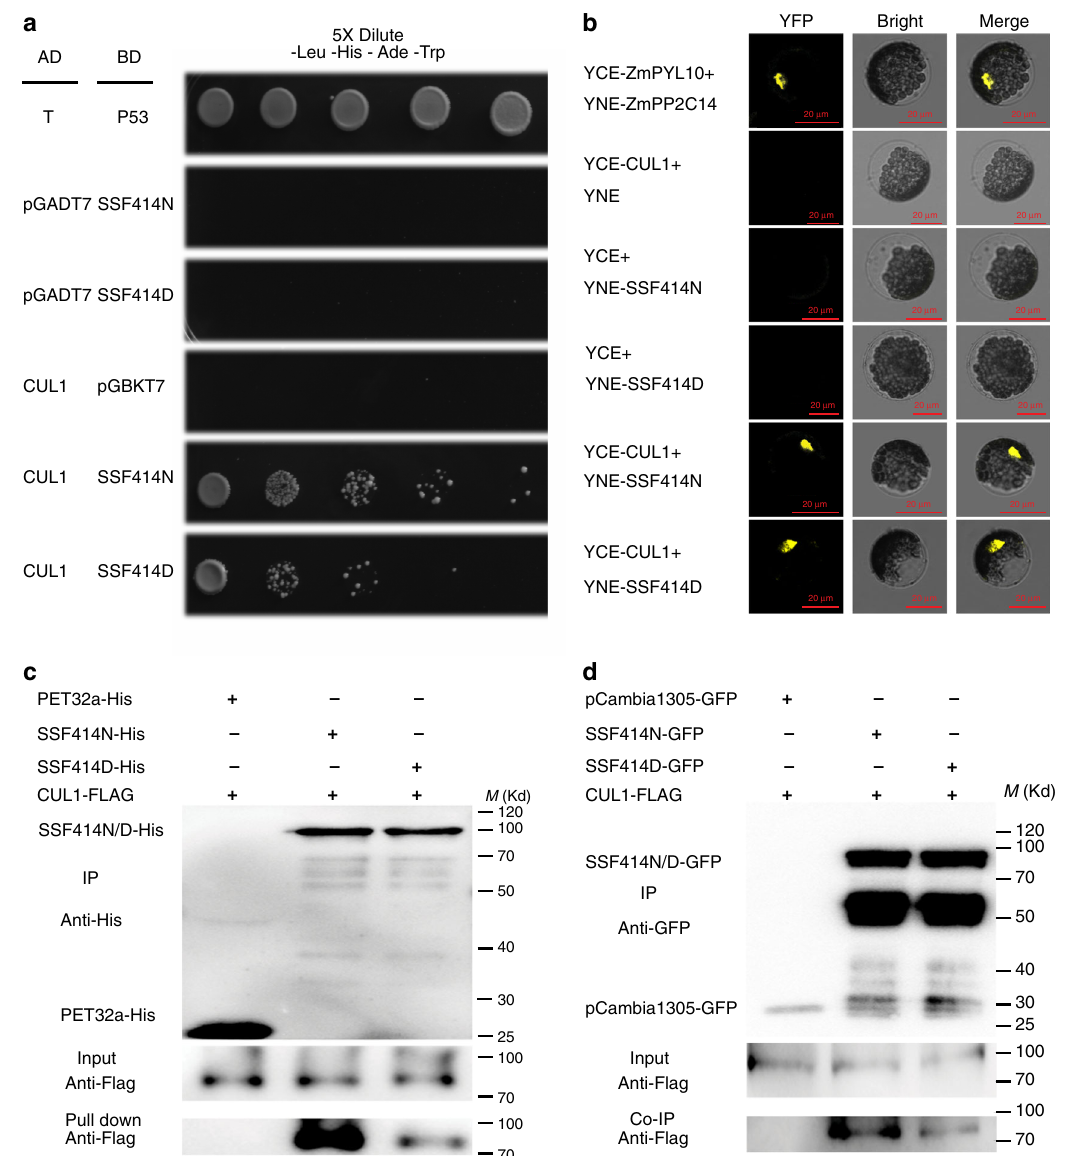
Fig. 4 CUL1 interacts with SSF in vitro and in vivo. a Yeast two-hybrid analysis of the interaction between SSF414N, 414D, and CUL1. The yeast culture was quanti fi ed and diluted in a 5× series and grown on YEP medium without leucine, tryptophan, adenine, and histidine. The same amount of yeast cells was grown from the start in each assay. The interaction of T and P53 was used as a positive control. The interactions between the empty vector AD with SSF414N or SSF414D and the empty vector BK with AD-CUL1 were used as negative controls. b SSF414N or SSF414D fused to the N-terminus of YFP was tested for its ability to bind to CUL1 fused to the C-terminus of YFP. Yellow fl uorescence and a bright- fi eld image were recorded and merged. The N- terminus of YFP alone plus CUL1 fused to the C-terminus of YFP and the C-terminus of YFP plus SSF414D or 414N fused to the N-terminus of YFP were used as negative controls. The interaction of ZmPYL10 and ZmPP2C14 was used as a positive control. Twenty cells were examined for each transformation. c Beads containing a His tag or His-fused SSF414N or SSF414D were tested for binding of Flag-fused CUL1 expressed in tobacco. The bound proteins were immunoblotted with anti-Flag antibody. pET32a is shown as a negative control. d Co-IP analysis of SSF414N-GFP or SSF414D-GFP cotransformed with Flag-CUL1 into Arabidopsis protoplasts. The expressed proteins were immunoprecipitated using GFP-Trap beads and then detected with anti-Flag antibody. pCambia1305-GFP is shown as a negative control. These experiments were repeated at least three times, and the same results were obtained. Source data are provided as a Source data fi